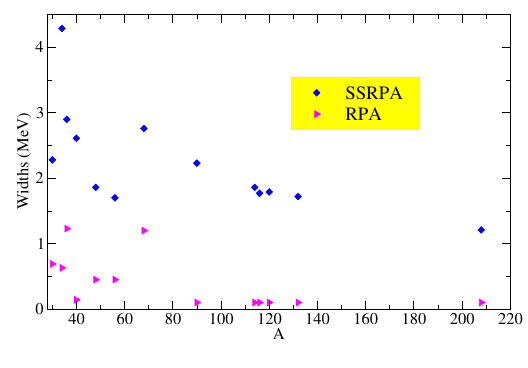
Figure 3. (a) SSRPA results for 48 Ca shifted by 1.5 MeV (blue area) compared with the RPA strength (black line) and with the experimental values (red circles), obtained with the parametriza- tion SGII. (b) Same as in (a) but the results are obtained with the parametrization SLy4 and the shift of the SSRPA spectrum is larger (2.7 MeV).